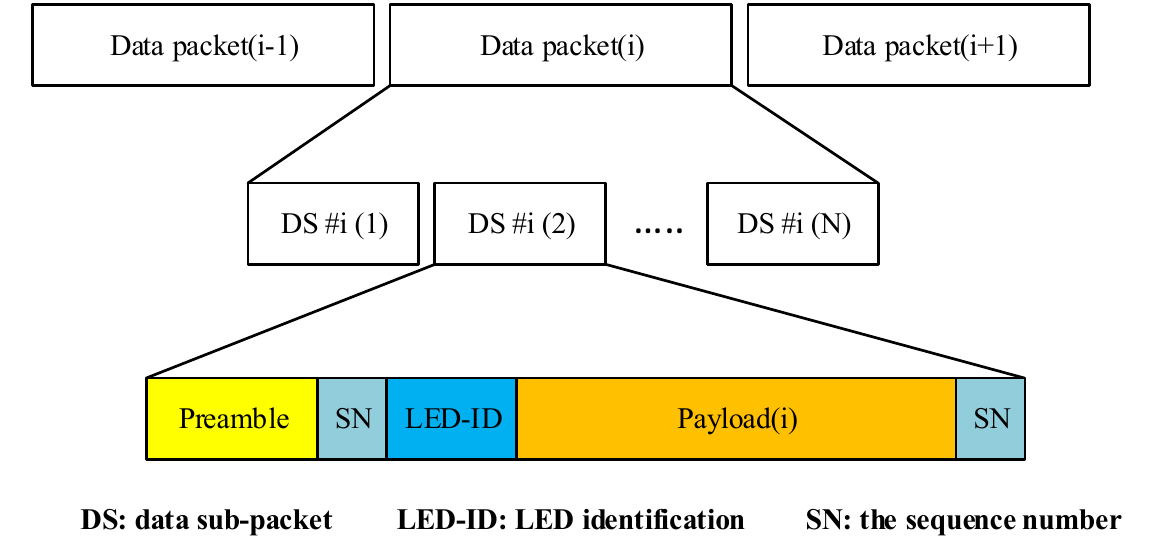
Figure 12. The reference architecture of the MIMO C-OOK data packet.